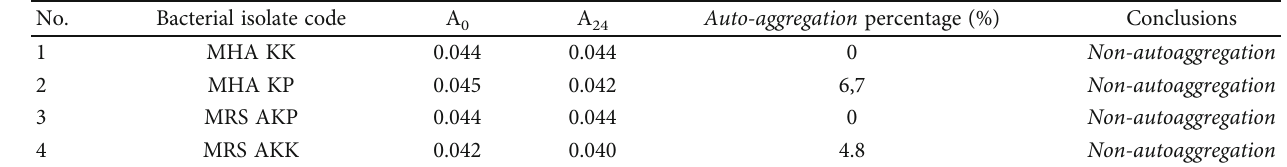
Table 3: Autoaggregation test results.